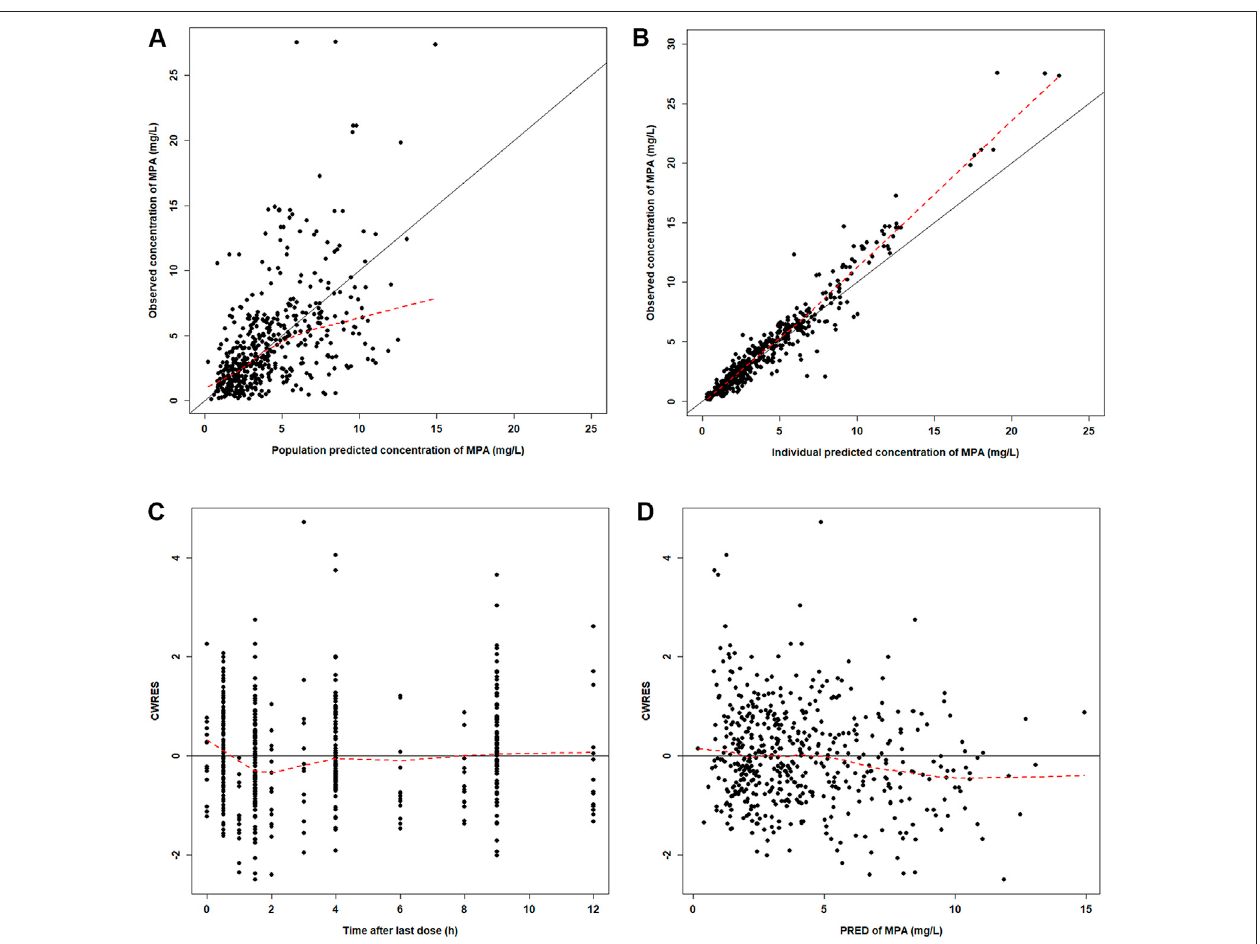
FIGURE 2 | Diagnostic plots for the fi nal PK model. (A) Observed versus population-predicted concentrations (DV vs. PRED). (B) Observed versus individual- predicted concentrations (DV vs. IPRED). (C) Conditional weight residual error versus time (CWRES vs. TIME). (D) Conditional weight residual error versus population- predicted concentration (PRED) (CWRES vs.